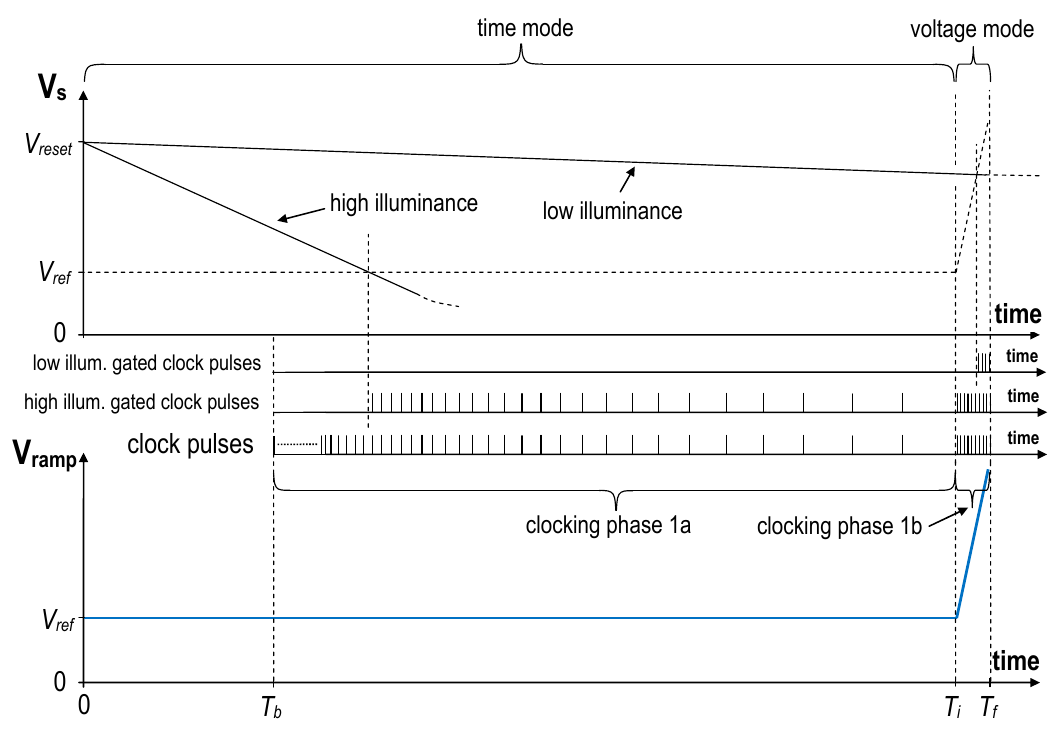
Figure 2. Principle of the hybrid conversion in the proposed pixel ‐ ADC.